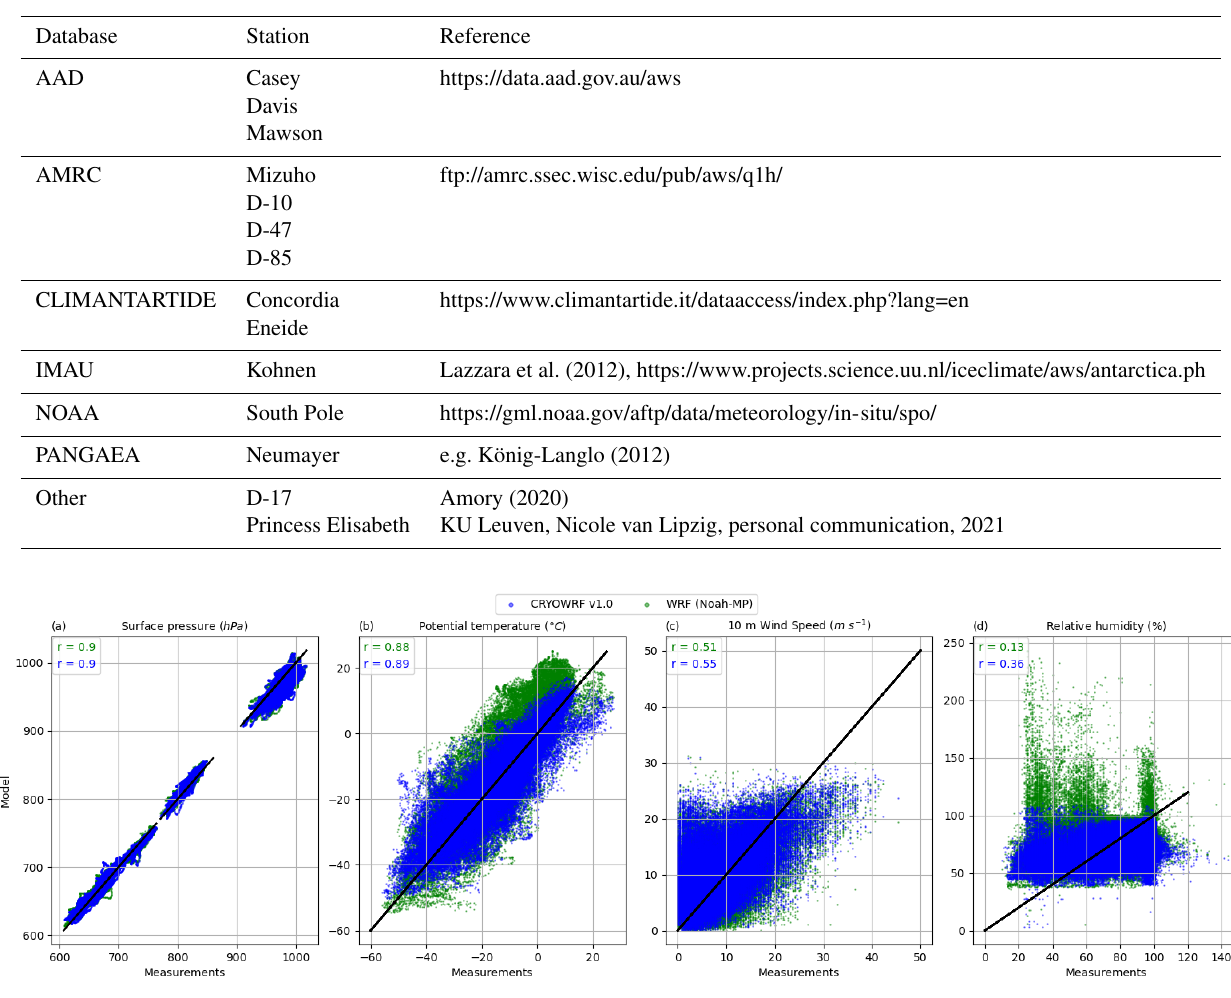
Figure 5. Correlation plots between CRYOWRF time series output (blue) and measurements. All measurements are consolidated. For com- parison, results with Noah-MP are shown (green). The correlation results are presented for surface pressure (a) , 2m potential temperature (b) , 10m wind speed (c) , and 2m relative humidity (d)